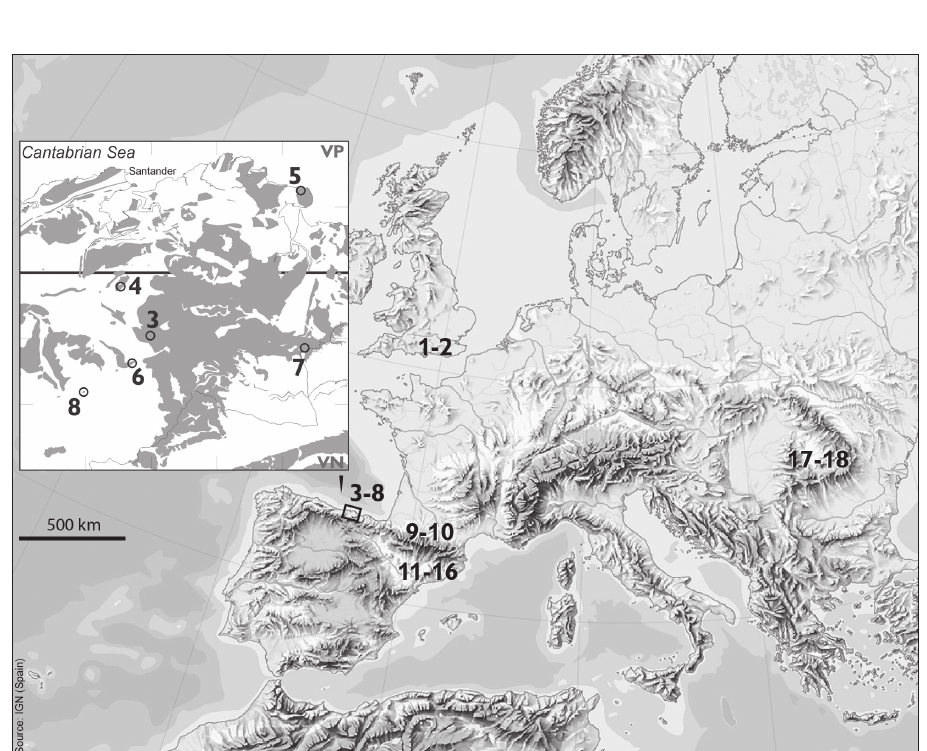
Figure 1. Maps showing the collection sites of the material used in this paper (Nos 1–8), previously published material (Nos 9–18, see Table 2) and areas with carbonate rock outcrops in Cantabria, N Spain (squares 10 × 10 km). See Table 1 for explanation of numbers 1–8, and note that neighbouring sites may share the same number